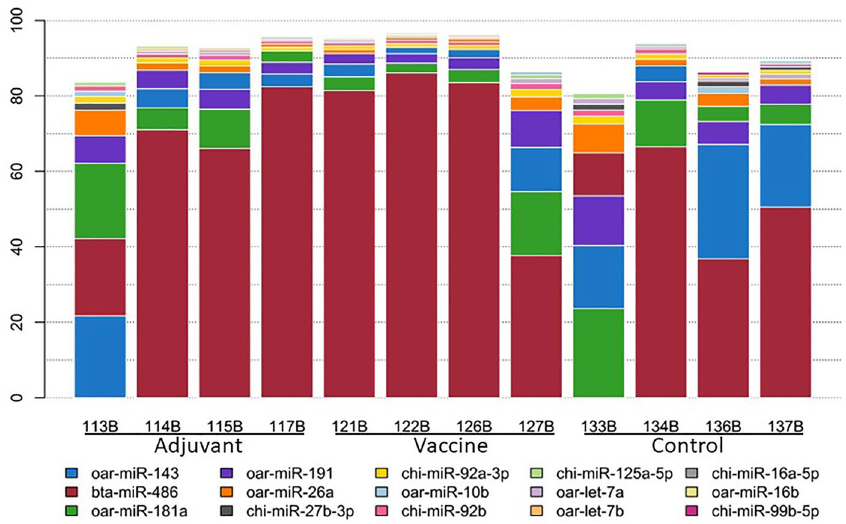
Figure 1. The 10 most highly expressed miRNAs in each sample. In the x-axis the samples and in the y-axis the percentage of the total reads for each miRNA. The bars are coloured by